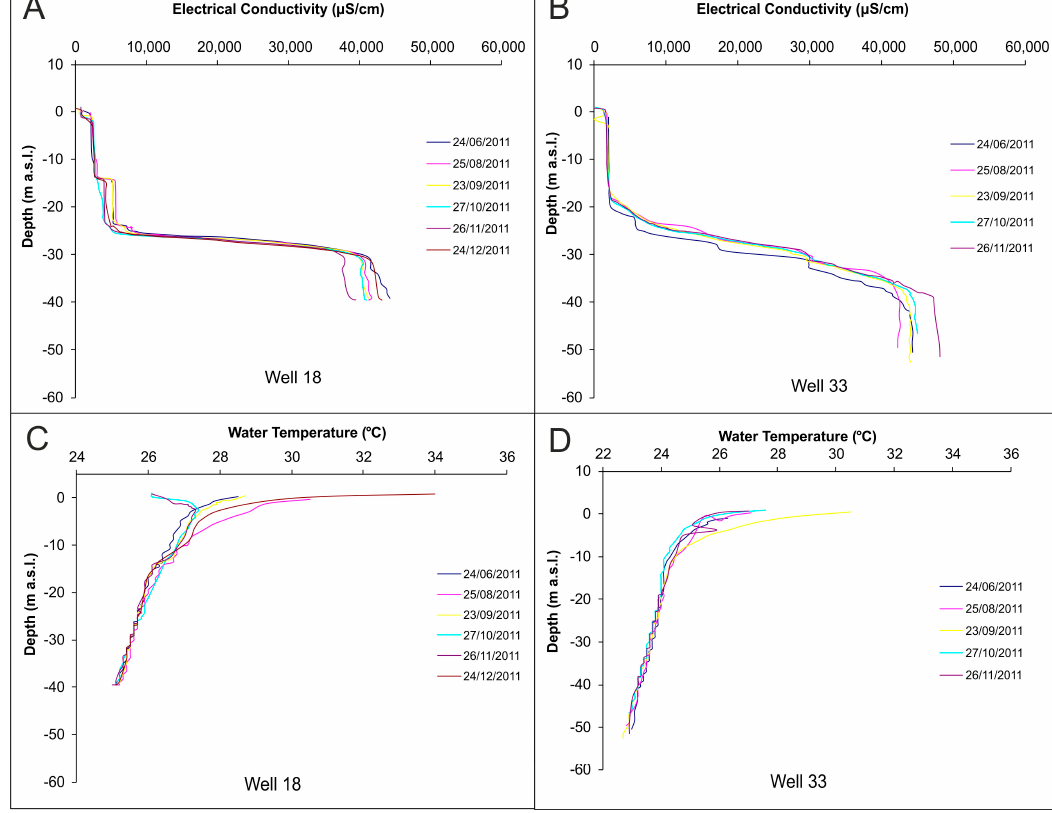
Figure 10. Electrical conductivity and temperature variation with depth in wells 18 (A and C, respectively) and 33 (B and D, respectively).